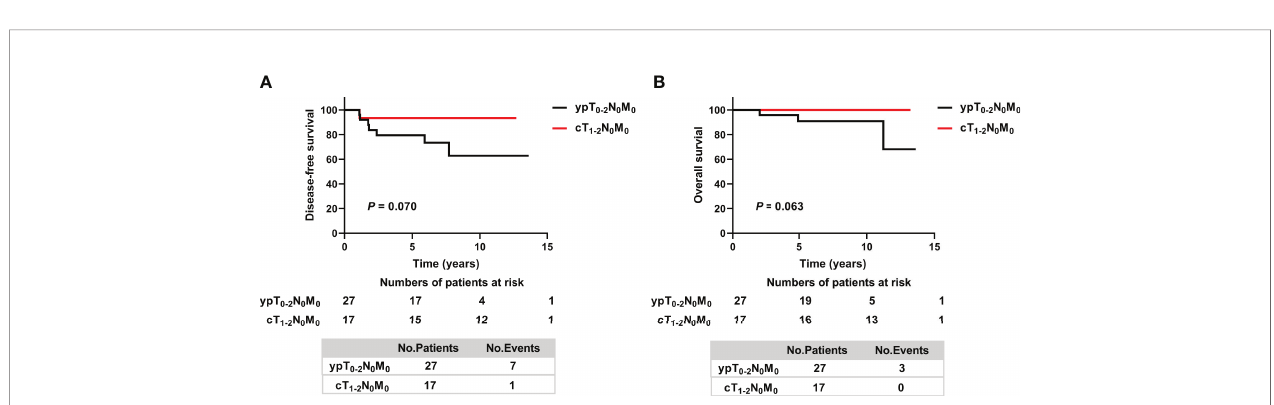
FIGURE 2 | Kaplan – Meier analysis of (A) Disease-free survival and (B) Overall survival in patients who achieved ypT 0-2 N 0 after NAC and in the PMRT and non- PMRT subgroups. PMRT, postmastectomy radiotherapy.